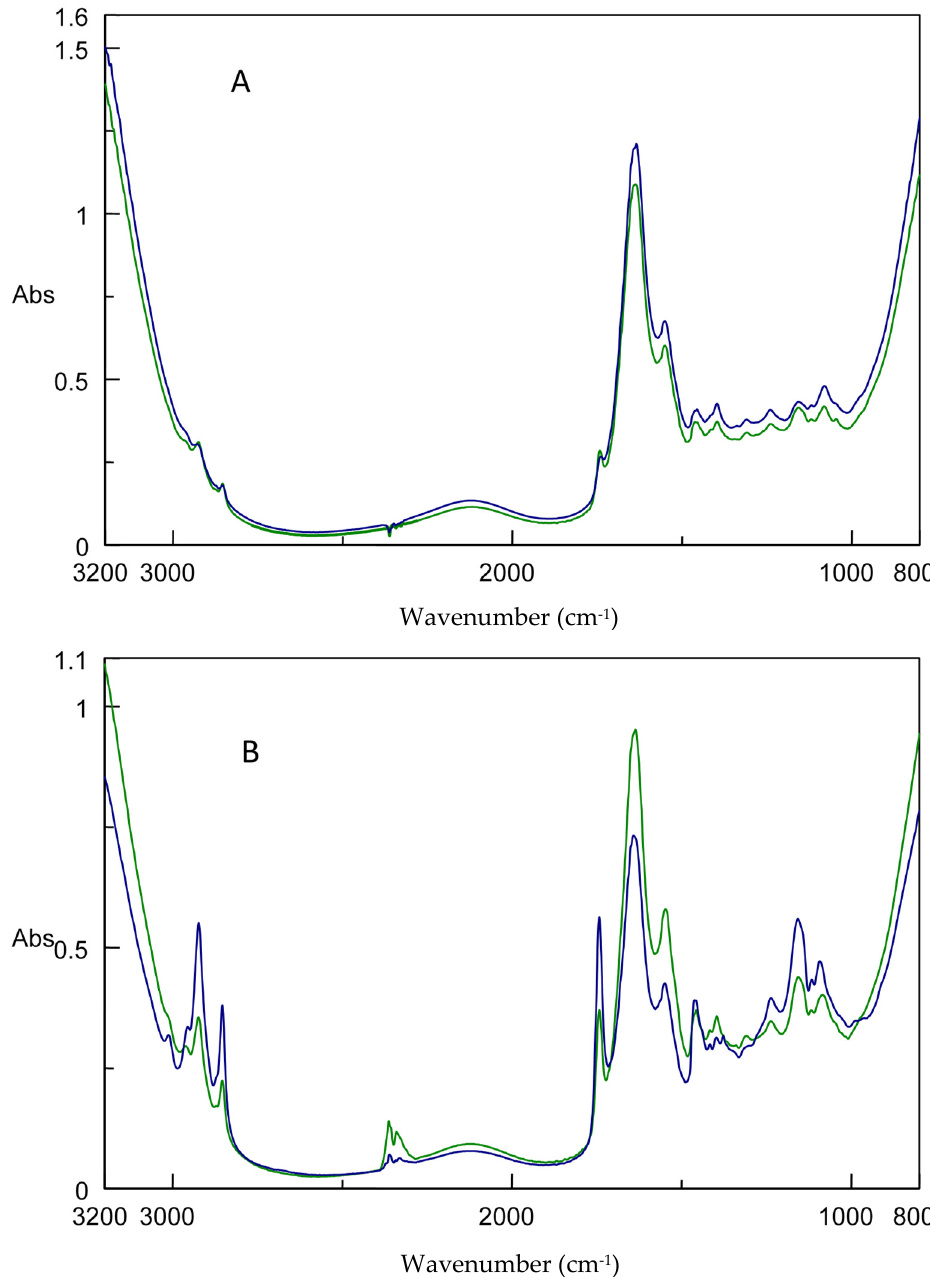
Figure 4. Representative FT-IR spectra corresponding to fresh (blue line, 4.95 log CFU/g) and spoiled (green line, 8.43 log CFU/g) gilthead sea bream fillet samples under aerobic ( A ) and MAP ( B ) storage conditions.